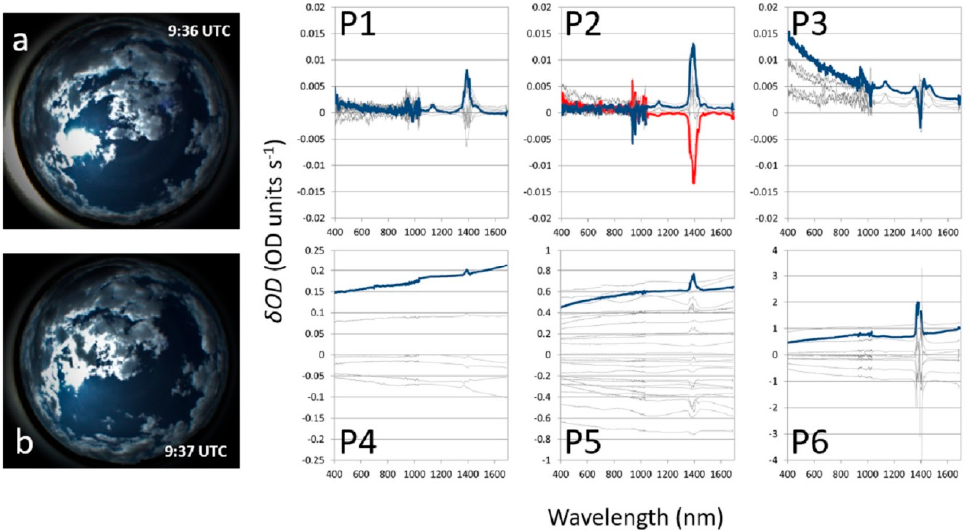
Figure 3. Images taken by the SONA hemispherical camera, the 28 June 2017, before ( a ) and during ( b ) the pass of a cloud patch through the line of sight of the spectrometer system. Plots P1 to P6 show 1-sec variations in apparent optical depth spectra along the corresponding periods. All plots show consecutive spectra within each period (in grey); some example spectra are drawn in blue or in red to easy viewing. Note that only plots P1 to P3 keep the same scale in the vertical axis. Units in the horizontal axes in P1 to P6 are nm.